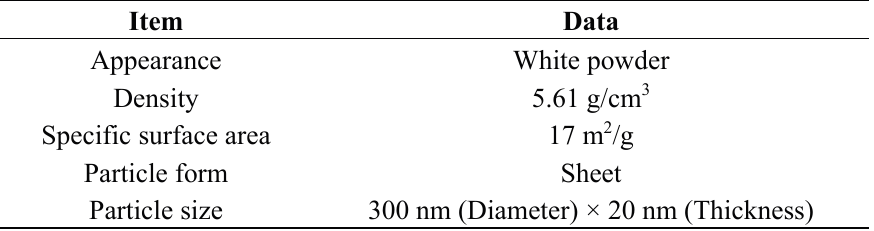
Table 1. Material properties and geometry of commercially ZnO powder.